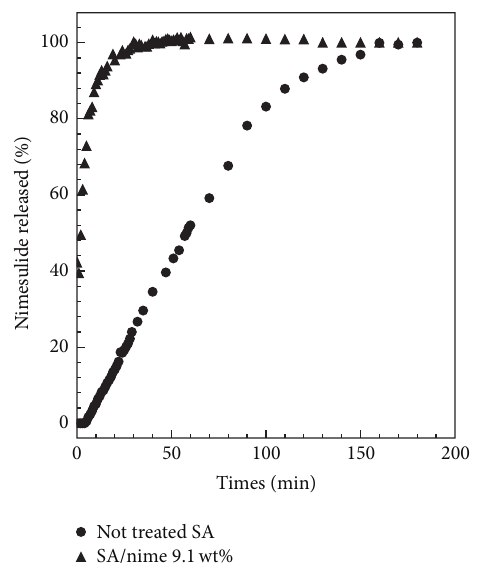
Figure6:ReleasekineticsofnimesulideinbufferphosphateatpH = 7.4